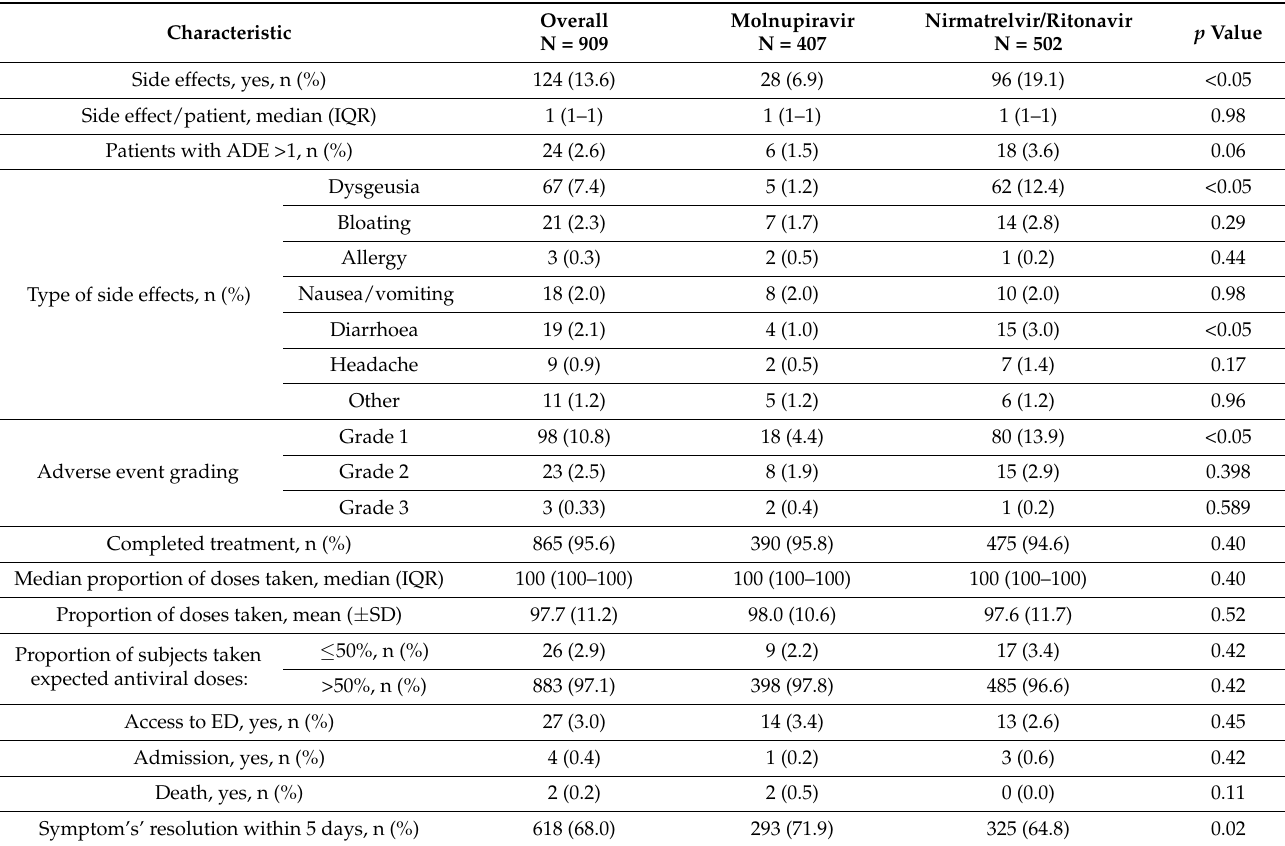
Table 2. Type, prevalence, and outcomes of adverse